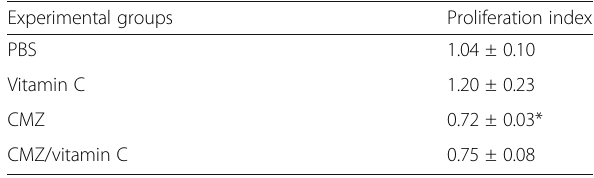
*Statistically significant vs. PBS-treated group ( P ≤ 0.05)